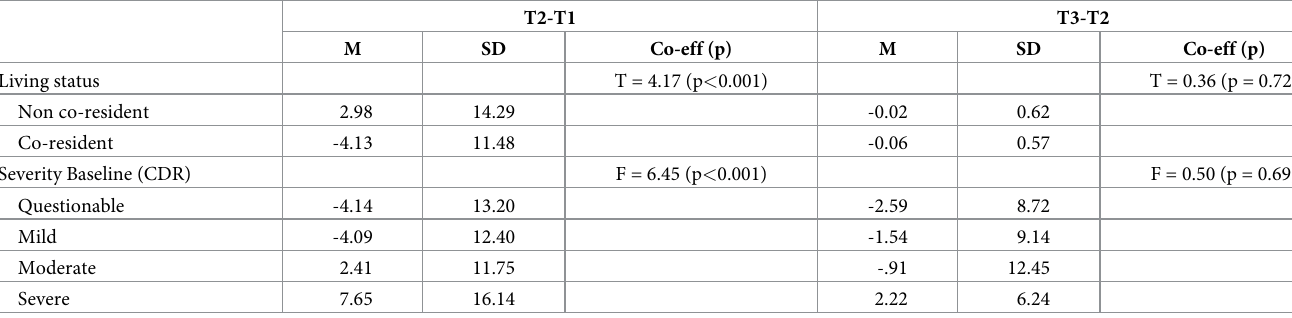
Table 3. Bivariate comparisons of C-DEMQOL (change between